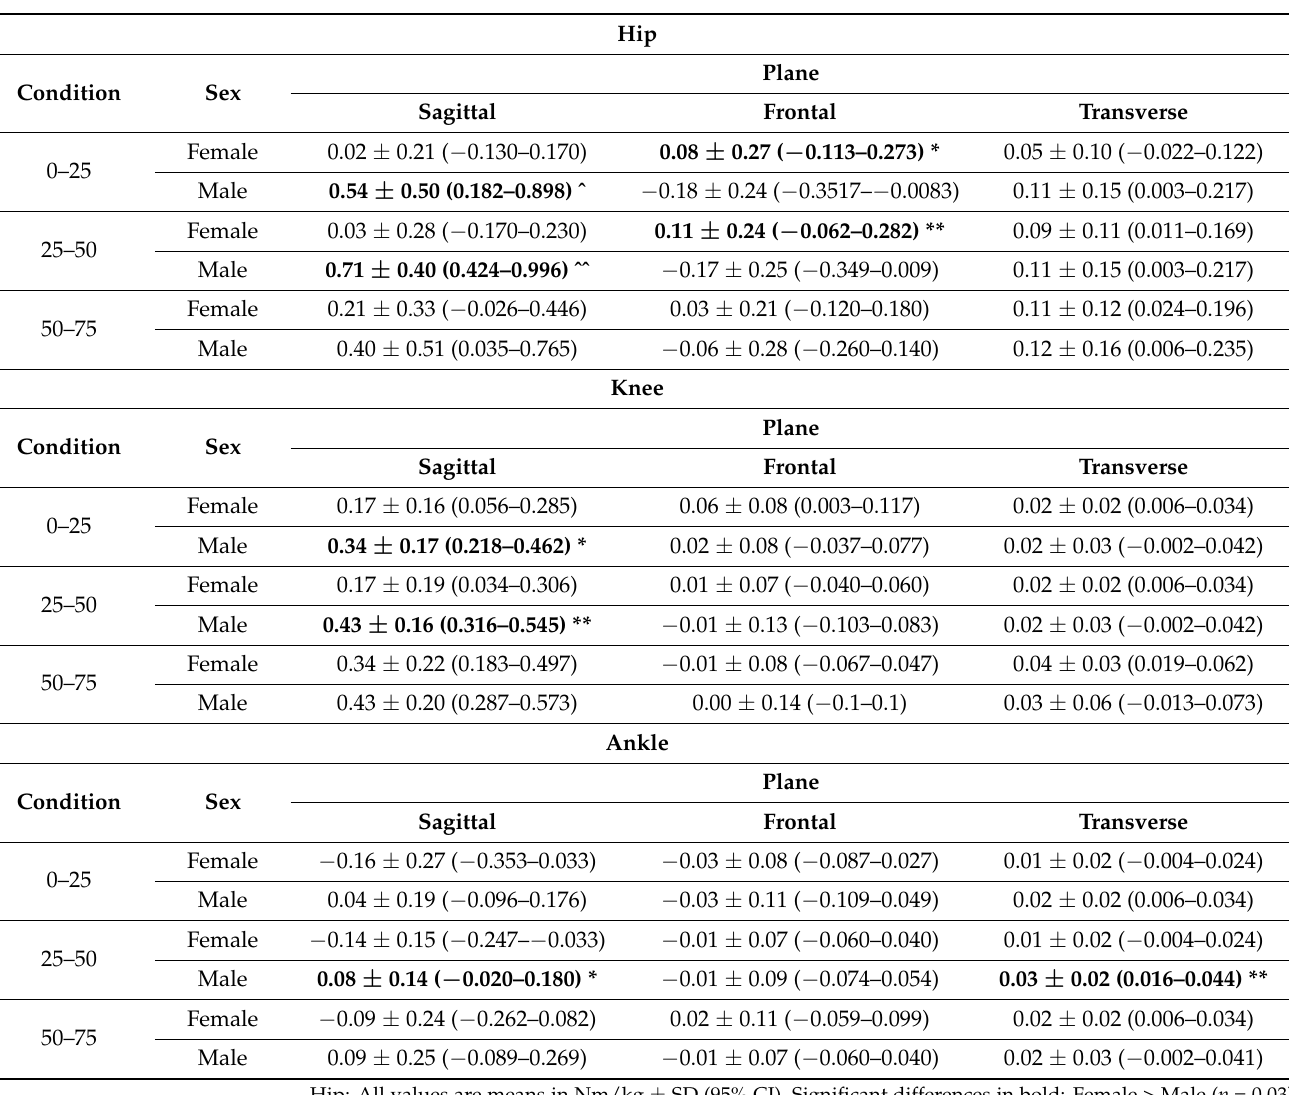
Table 2. Joint moments (sex comparison) initial